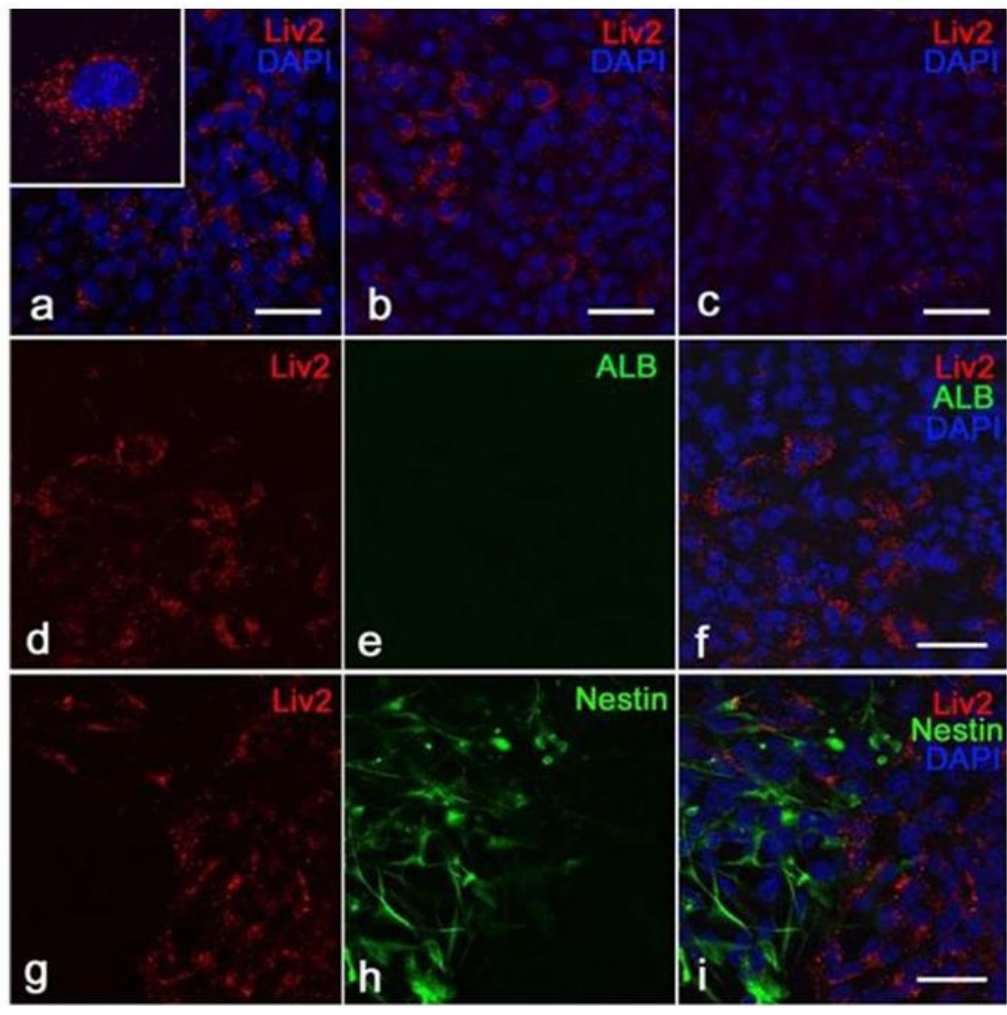
FIGURE 6. Another type of Liv2 chronological immunoreactivity in EB outgrowth (a, day 7; b, day 11; c, day 13) and immunocytochemical analysis of ALB and nestin (d–f, ALB, day 18; g–i, nestin, day 23). There were many granules immunoreactive for Liv2 (red) in the peripheral cells in EB outgrowth (a). Fluorescent signals were located only in the cytoplasm around the nuclei (a, inset). The number of granules decreased with prolongation of culture of EB outgrowth (b,c). The cells containing many granules did not merge with signals for ALB (f) or nestin (i). Bars = 50 µ